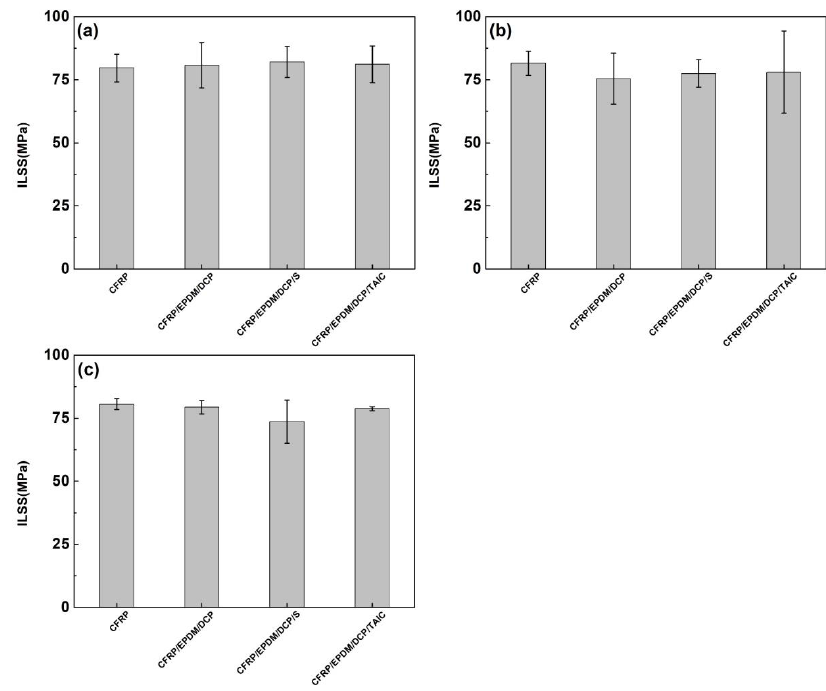
Figure 10. The ILSS of CFRP. ( a ) 160 °C, 20 min. ( b ) 160 °C, 30 min. ( c ) 160 °C, 40 min.